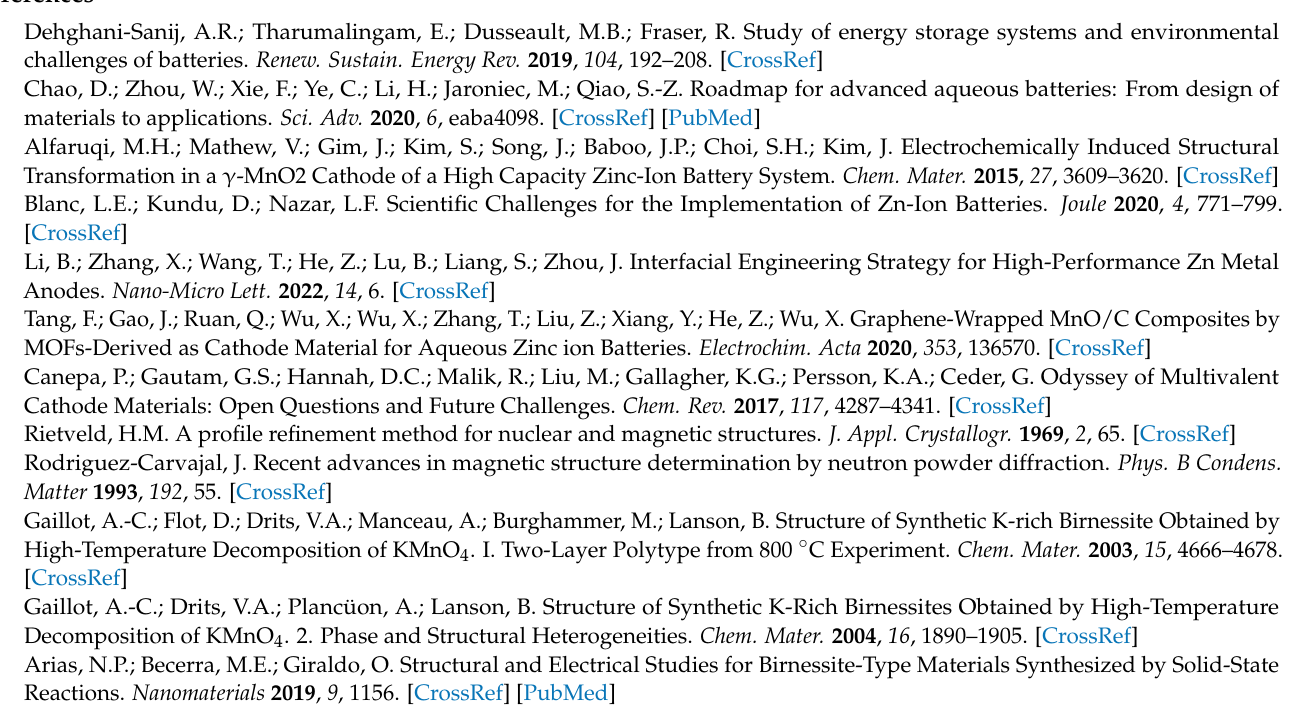
Table S1. Weight loss from ATG data (%) and structural formulas for birnessite-type material obtained from EDX and ATG